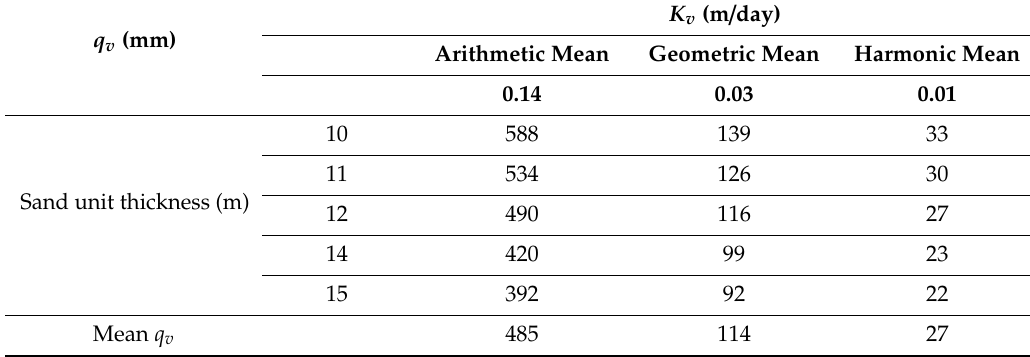
Table 3. Total vertical seepage q v (mm) calculated over the entire basin area for the considered time interval 1971–2017 considering di ff erent sand unit thickness (10–15 m, [15,27,43]) and vertical hydraulic conductivity (0.14–0.01 m / day) ranges. Note for the calculations the following parameters are used: the total area of Quinto Basin is equal to 9252 hectares; area a ff ected by vertical seepage where the topography and water table are below sea level is equal to 2000 hectares; total ∆ h change through time as a result of subsidence is equal to = 0.53 m. K v is assumed 1 / 3 of K x (refer to paragraph 2.2.5. for K x